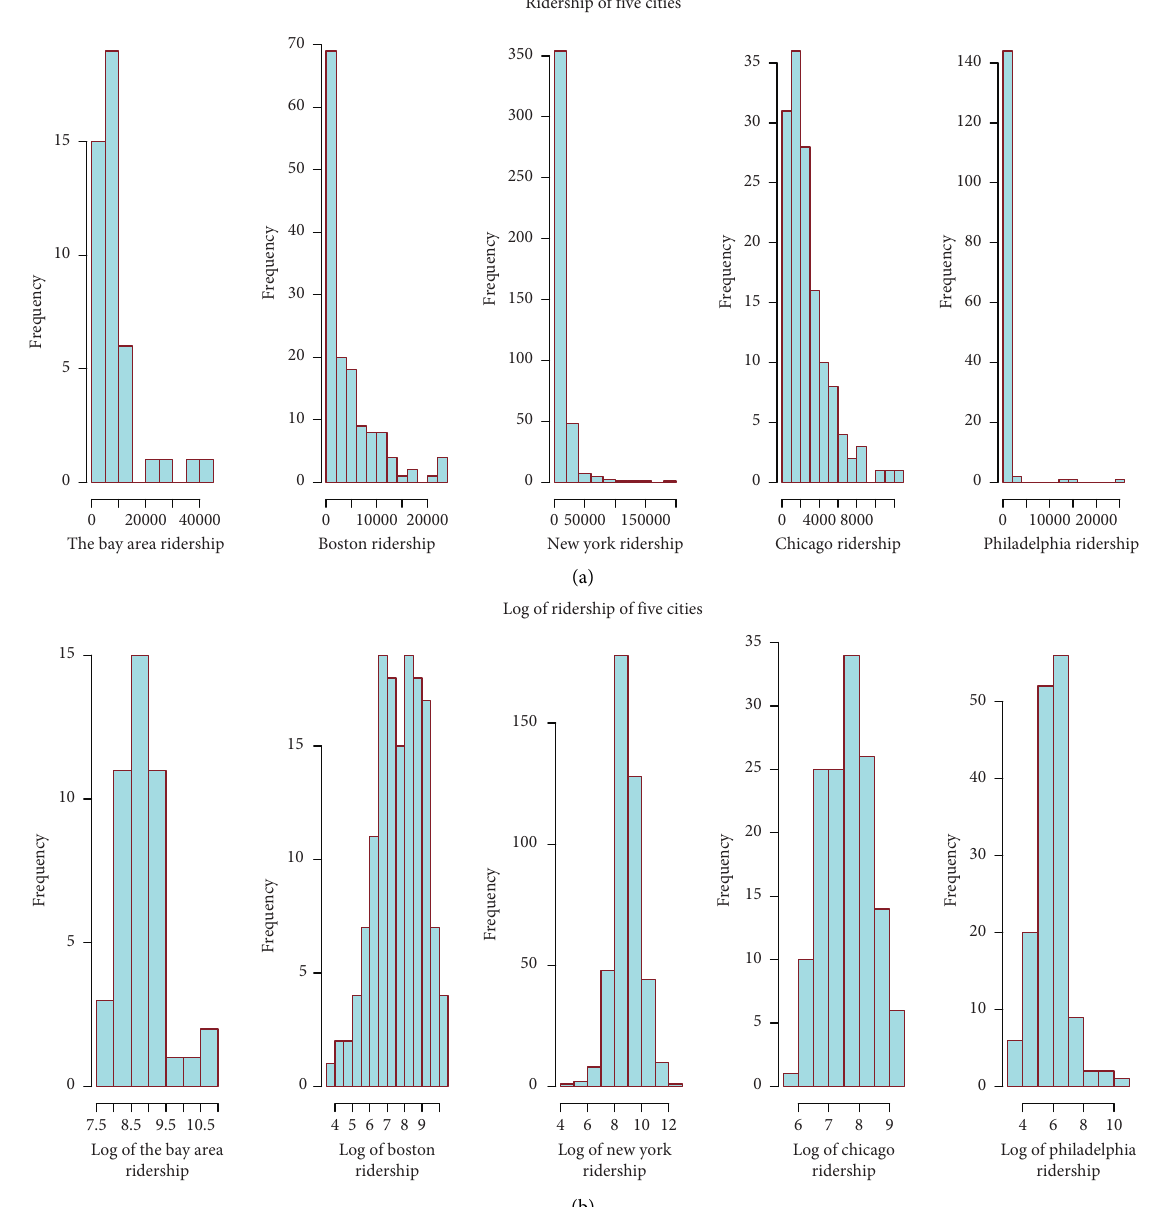
Figure 3: The histograms of ridership distribution of five selected urban rail transit